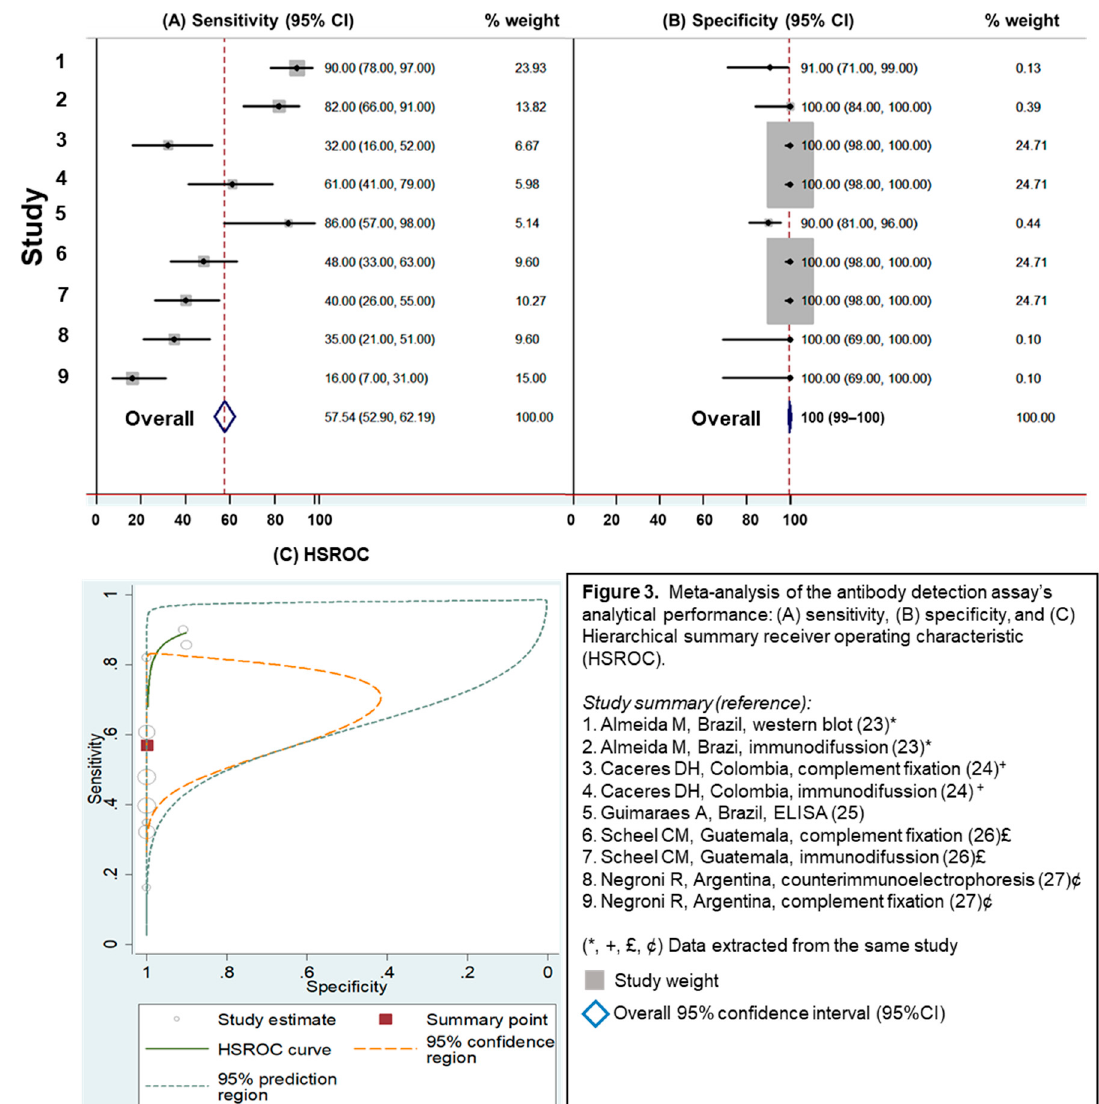
Figure 3. Meta-analysis of the antibody detection assay’s analytical performance: (A) sensitivity, (B) specificity, and (C) Hierarchical summary receiver operating characteristic (HSROC).